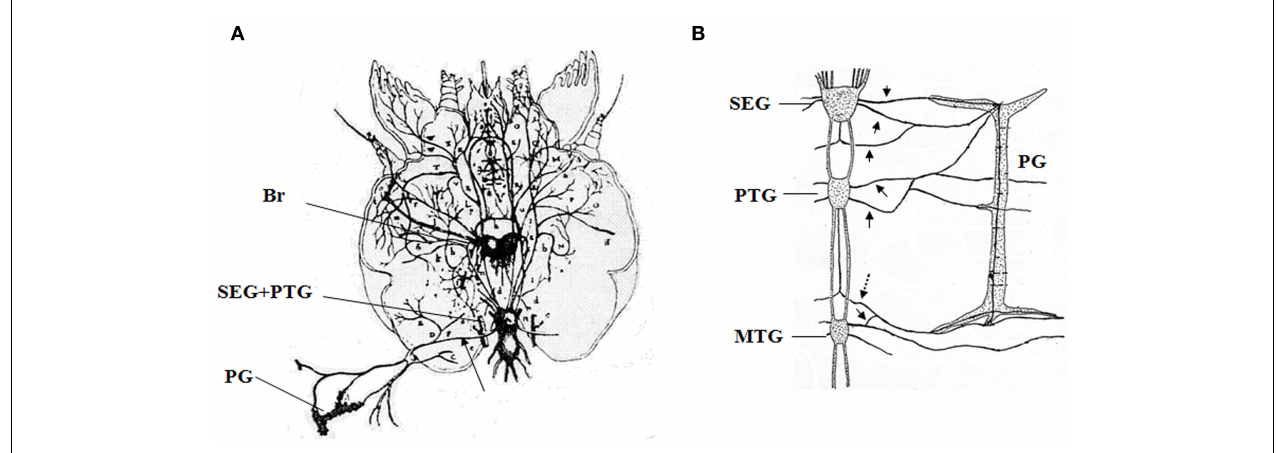
ganglia; MTG, mesothoracic ganglia; PG, prothoracic gland. Arrows indicate the neurons innvervating the PGs, and a dotted arrow indicates the BRFa/Orcokinin-neuron.These figures are partially modified from the original ones.